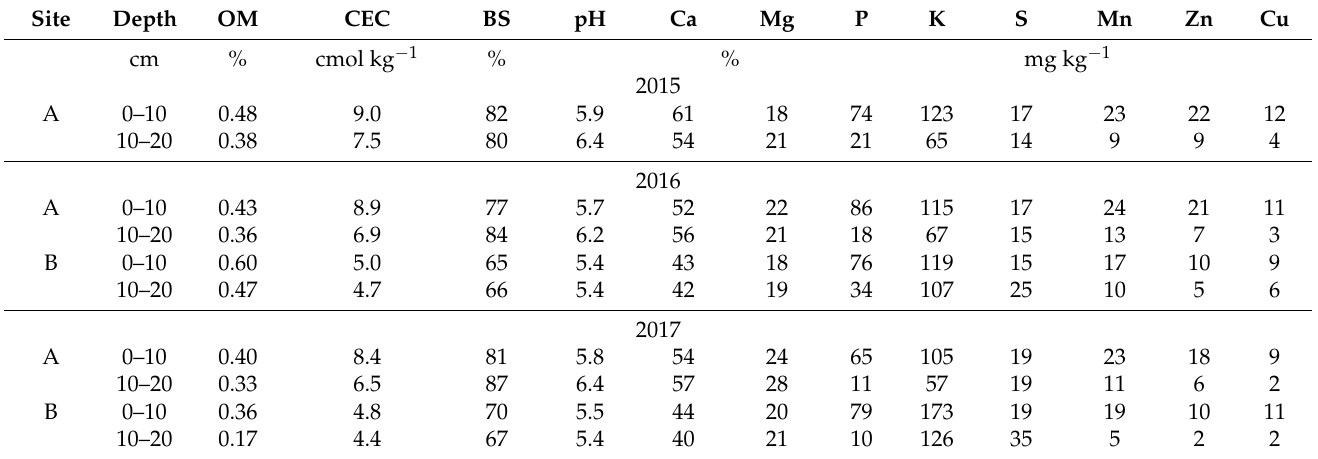
Table 1. Surface soil properties associated the two field sites used in the 2015-17 N studies.